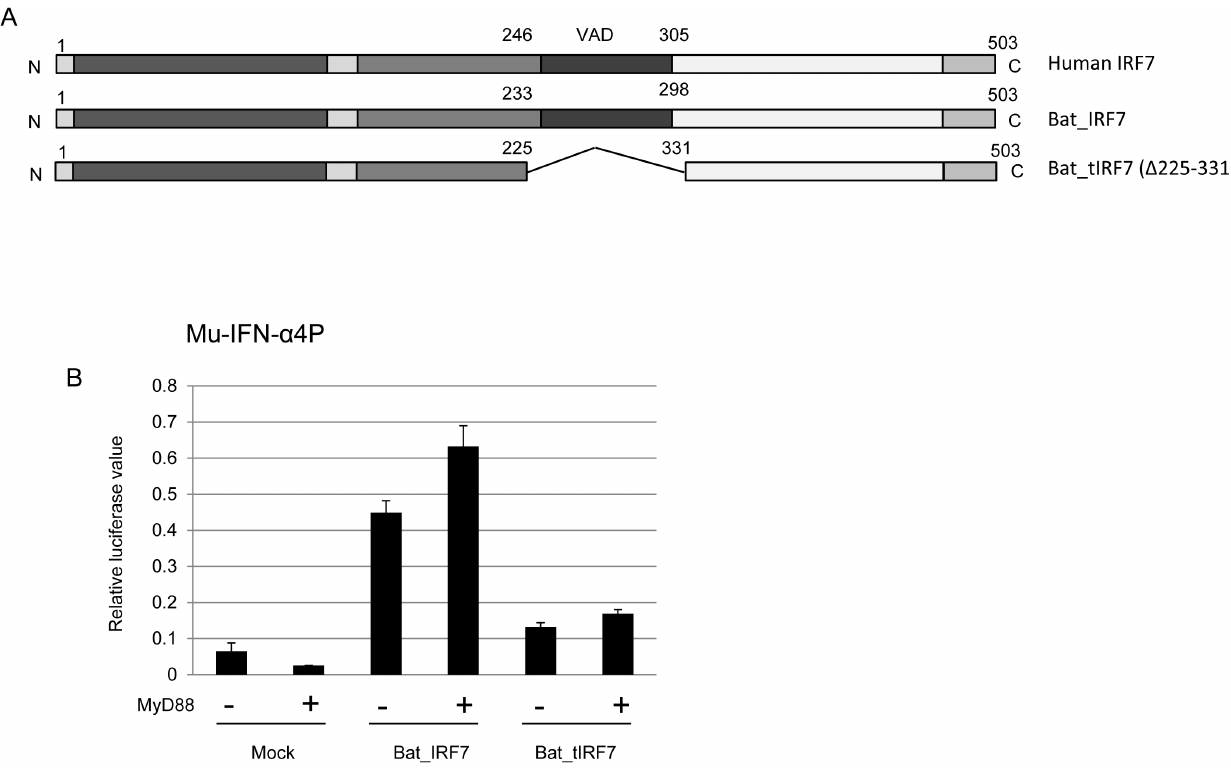
Figure 7. The VAD domain of bat IRF7 is functionally conserved with that of human IRF7. A. The full length human and bat IRF7 functional domain and a truncation mutant of bat IRF7 ( D 225–331, bat_tIRF7) are illustrated schematically. (B) Deletion of the VAD domain of bat IRF7 abolishes IFN transactivation. Bat IRF7 or bat tIRF7 plasmid was transfected into HEK293T cells with mouse IFN- a 4 promoter plasmid with or without bat MyD88 expression plasmid and luciferase activity was tested 30 h post-transfection. Results show mean values of two experiments and error bars represent standard errors.